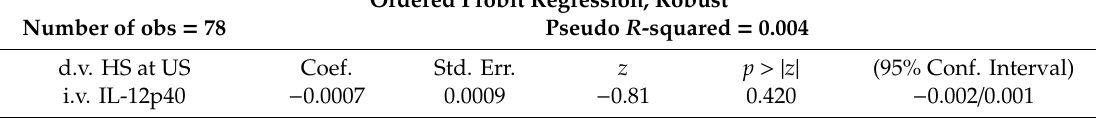
Legend to Table 8: HS at US, hepatic steatosis at ultrasonography; BMR, basal metabolic rate; IL-16, interleukin-16; IL-12p40, interleukin-12 subunit p40; SLD, spleen longitudinal diameter at ultrasonography; d.v., dependent variable; i.v., independent variable. In bold are highlighted the significant